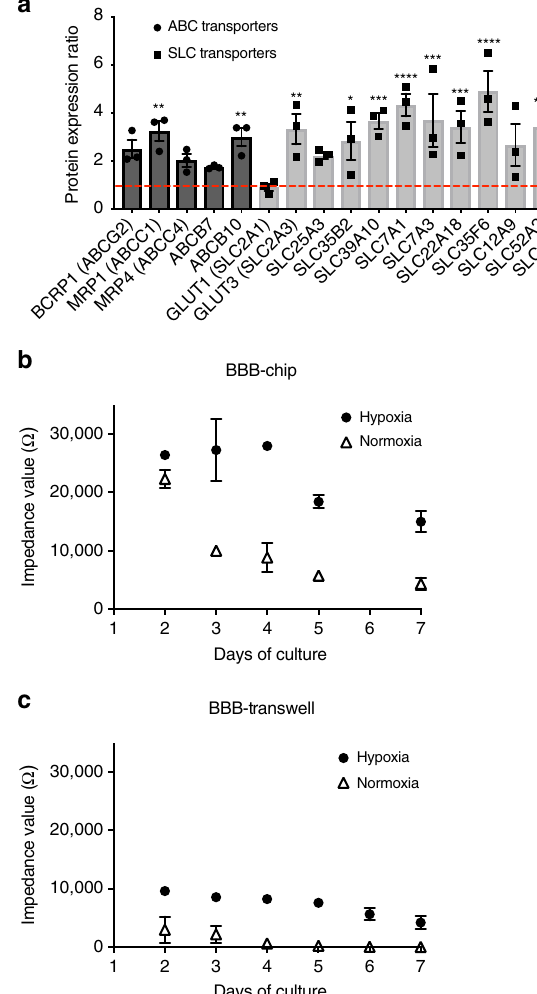
Fig. 2 Physical barrier functions of the human BBB reconstituted on-chip. a Graph showing protein expression ratios of ABC and SLC transporter proteins in the iPS-hBMVECs differentiated under hypoxic conditions relative to normoxic conditions. b Impedance values for the human BBB measured in the TEER chip over the fi rst 7 days of culture on-chip (recorded in the frequency range of 0.1 Hz – 100 kHz) with iPS-BMVECs that were differentiated under hypoxia (closed circles) or normoxia (open triangles). c Impedance values for the BBB formed by the same human astrocytes, pericytes, and iPS-hBMVECs that were differentiated under hypoxia (closed circles) or normoxia (open triangles) but cultured in static Transwell inserts measured by TEER measurement machine (EVOM2). Data are represented as ± SE, N = 3. Statistical analysis is two-way ANOVA with Tukey ’ s multiple comparisons test; * P < 0.05; ** P < 0.001; *** P <